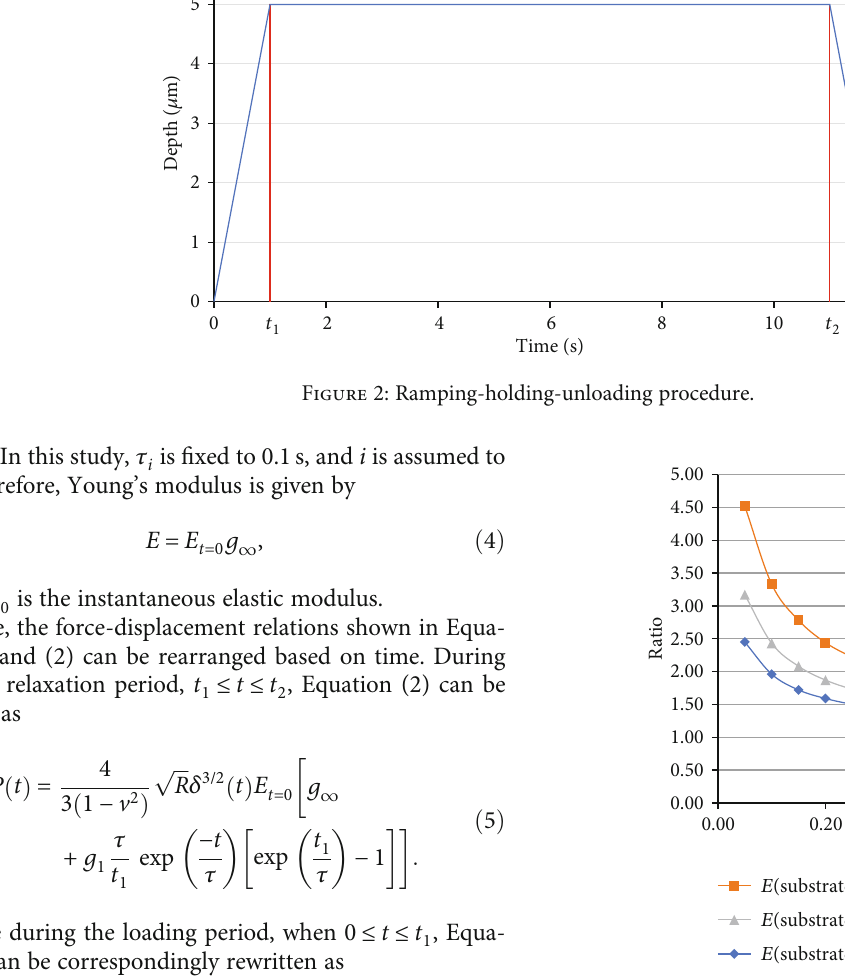
Figure 3: Ratios of Young ’ s modulus based on Equation (12) as a function of